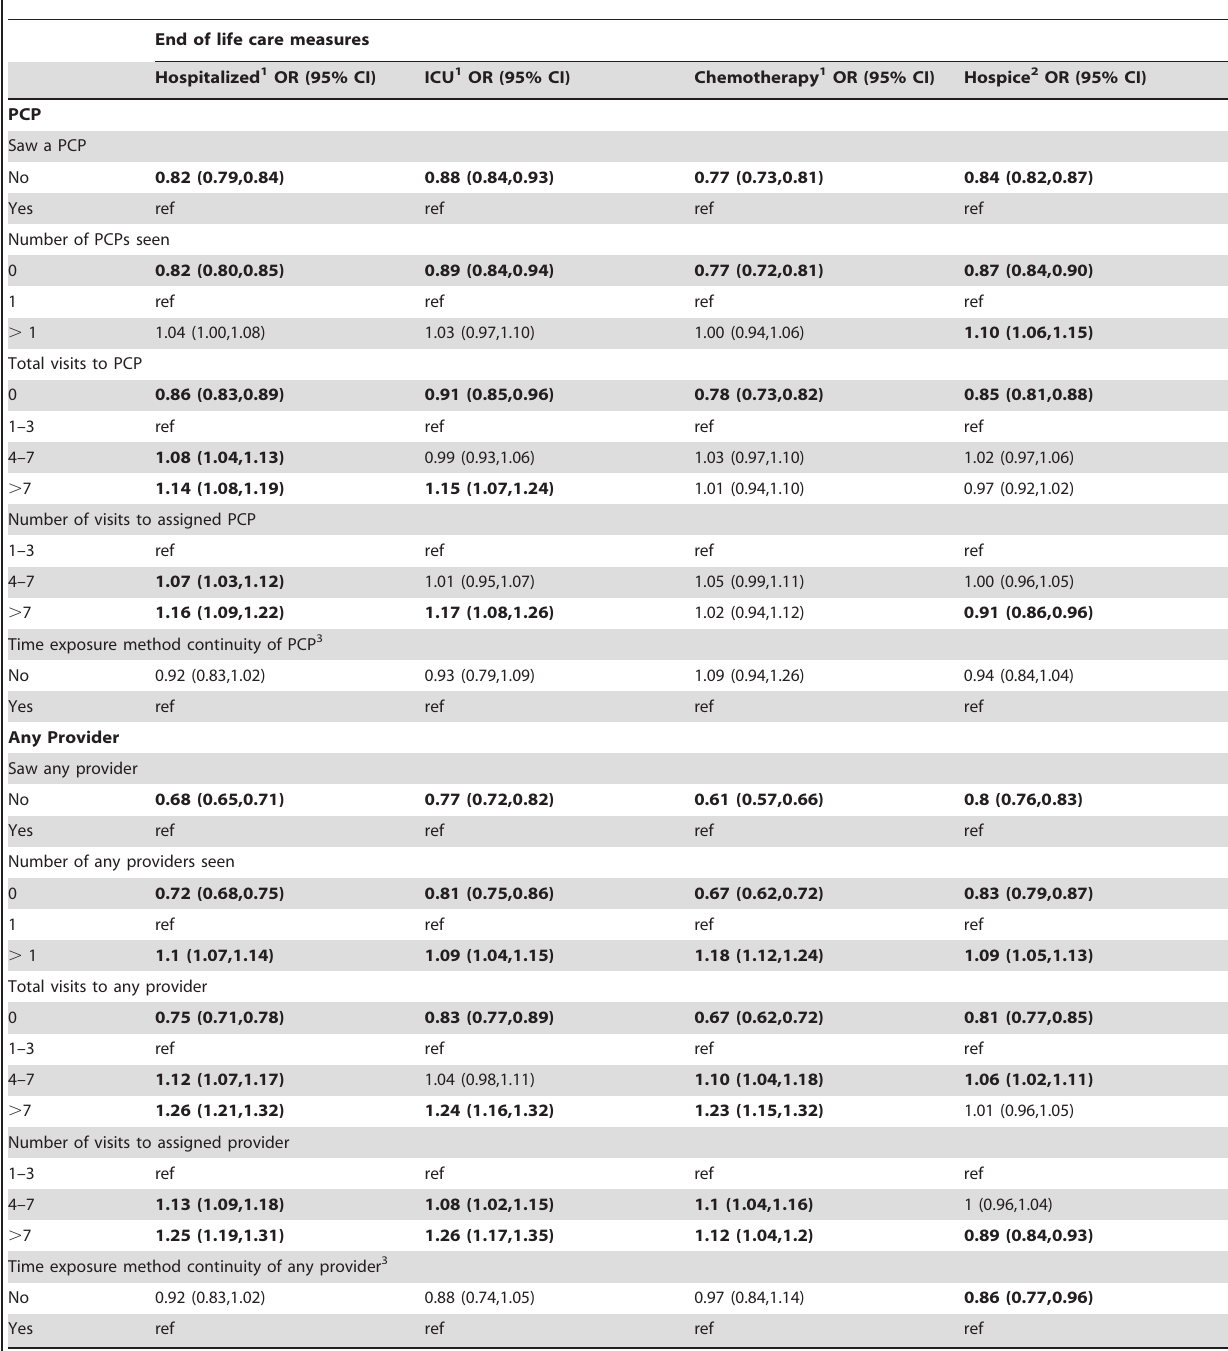
Table 3. Multivariable analyses of the associations between provider continuity measures and end-of-life